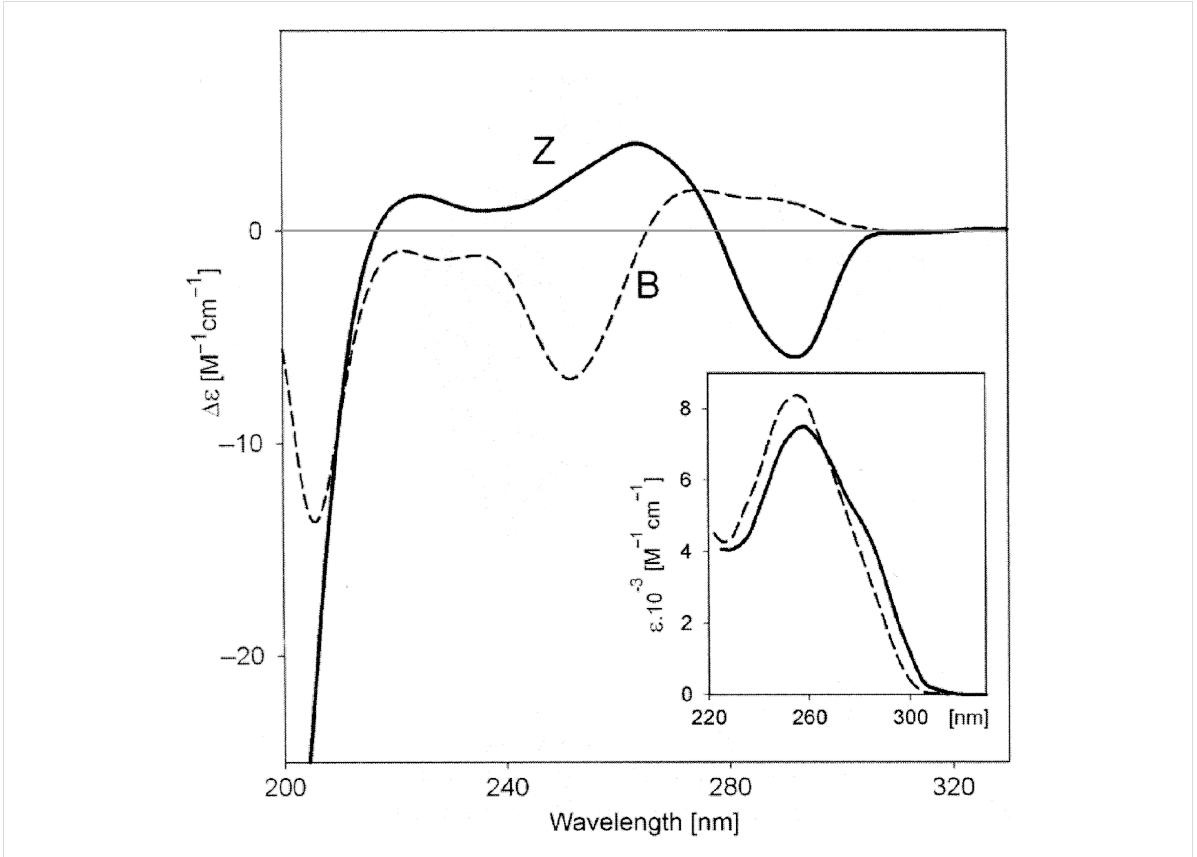
Figure 4: ECD and UV (inset) spectra of poly(dG-dC)–poly(dG-dC) in the B and Z-form, obtained in 59% and 67% aqueous trifluoroethanol, respec- tively. Adapted from [15].